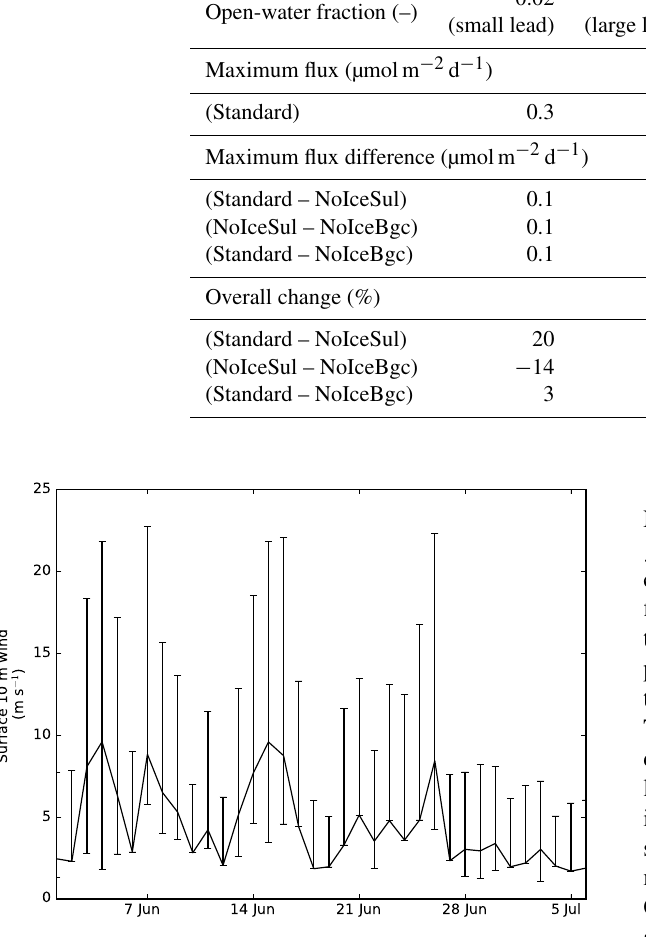
Figure 8. Time series of daily mean surface 10m wind speed (ms − 1 ) observed at the Resolute airport (located within 7km of the study site) during the melt period in 2010. The upper and lower ver- tical bars associated with the daily mean values represent the daily maximum and minimum values,